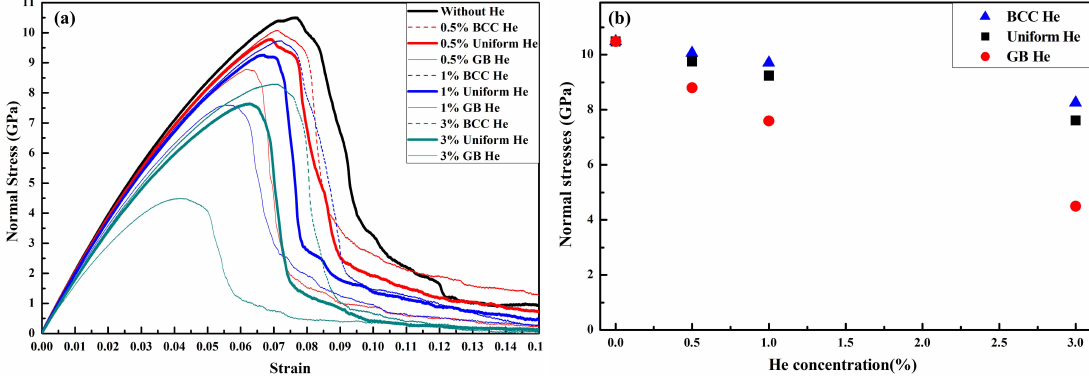
Figure 6. ( a ) Normal stress-strain curves for moles with different He concentration and distribution under uniaxial tensile strain; ( b ) The maximum normal stresses of models with BCC He, uniform He and GB He.